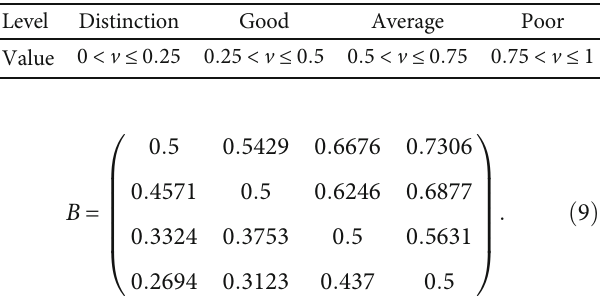
Figure 3: Architecture of multilayered evaluatory factors. Table 1: Fuzzy comment